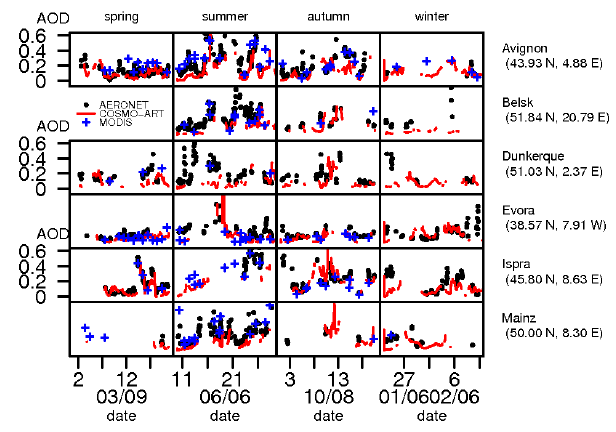
Fig. 8. Timelines of aerosol optical depth (AOD) at select AERONET stations in Europe for the different periods. Shown are AERONET measured values (black circles), MODIS derived AOD (blue asterisks) and the simulated AOD values (red lines). AERONET data has been cloud-screened by the data provider. MODIS data is also cloud screened. Modelled values are masked if simulated total cloud cover was above 25%.